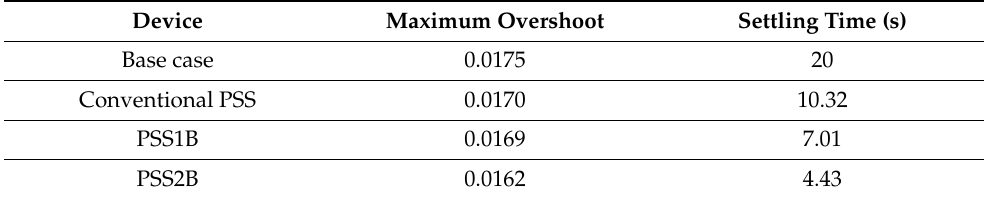
Table 21. Maximum overshoot and settling time of rotor speed at light loading.